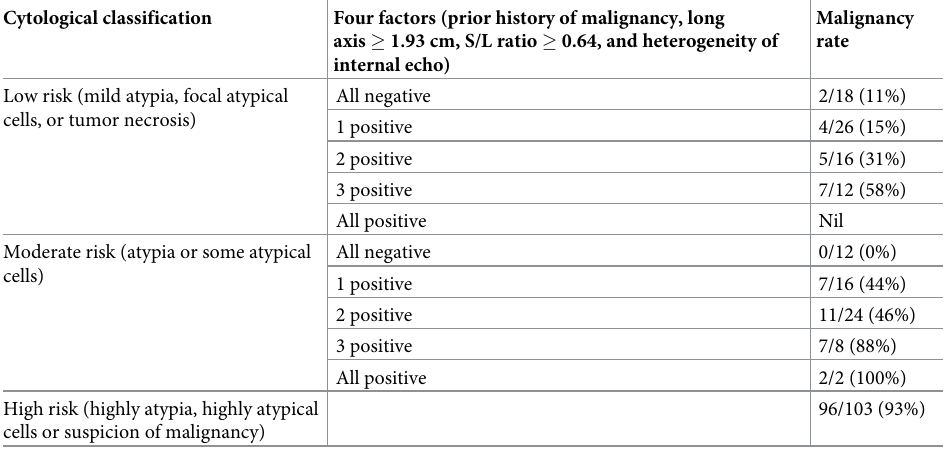
Table 4. The final malignancy rate was determined by using the cytological classification and other four predic- tors in patients who had neck LNs with indeterminate cytology. Cytological classification